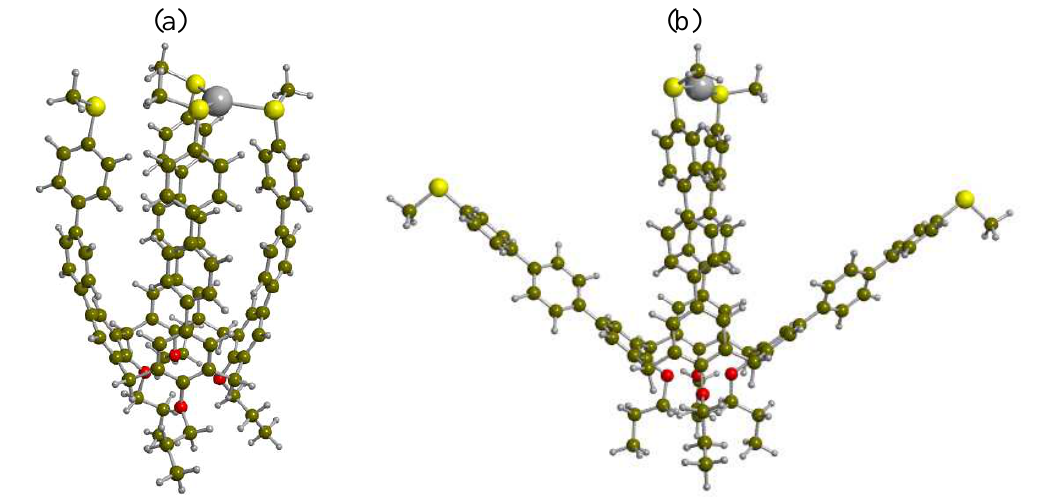
binding mode. The drawings were performed by 2v